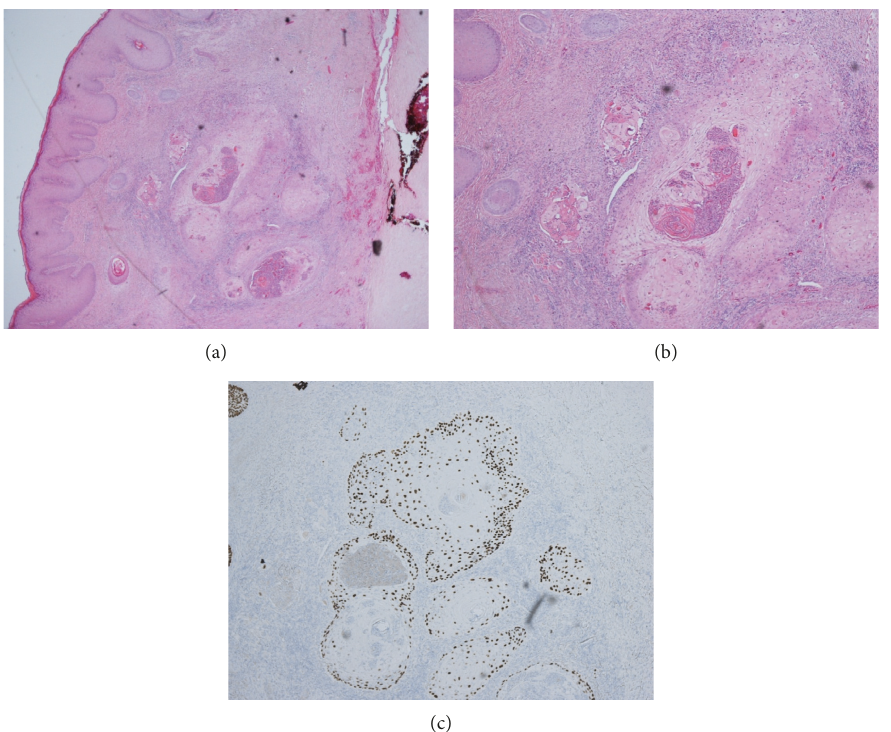
Figure 9: (a) Photomicrograph of wide locally excised ulcerative, crusted lesion (H&E stain) at × 2 magnification. Nests of squamous cell carcinoma are seen infiltrating the dermal tissue without involvement of the underlying cartilage (cartilage is seen in the right-hand field). (b) × 4 magnification of the same area; this demonstrates infiltrating nests of keratinising squamous cell carcinoma associated with a host